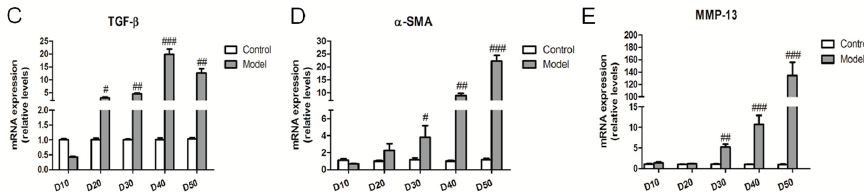
Figure 4. High fat-sucrose diet caused hepatic fibrosis in NASH rats. The hepatic fibrosis of SD rats fed a high fat-sucrose diet on day 10, 20, 30, 40, 50. ( A ) Sirius red (SR) staining; ( B ) Semi-quantitative analysis of the SR staining of every group. The relative fibrosis gene TGF- β ( C ), α -SMA ( D ), MMP-13 ( E ) mRNA expression. The values are expressed as the means ± SEM ( n = 6). Compared with the corresponding control group, # p < 0.05, ## p < 0.01, ### p < 0.001.